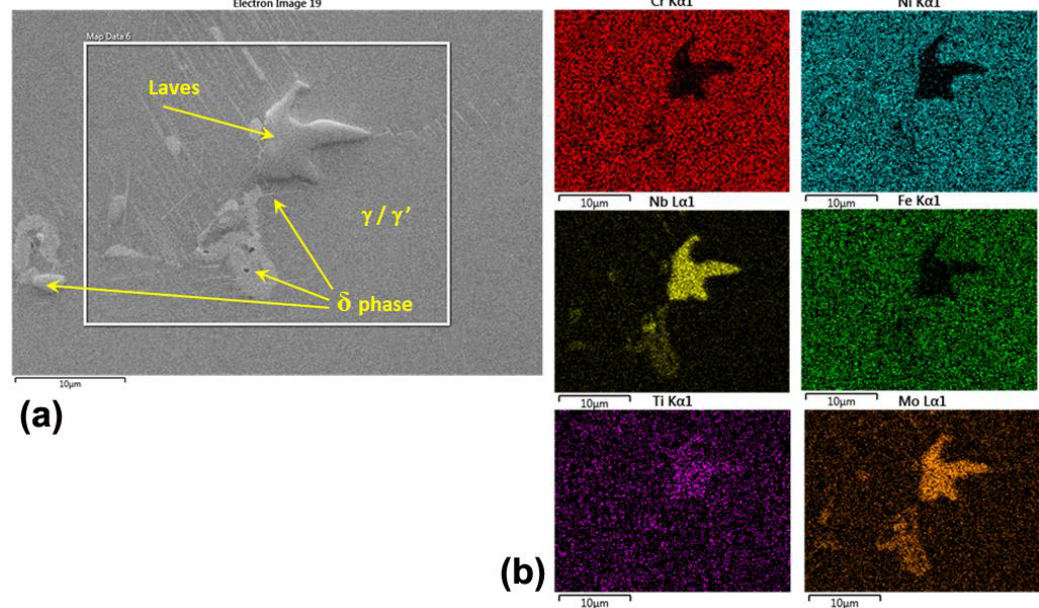
Figure 12. FESEM micrographs for IN718 alloy obtained by investment casting. ( a ): with standard heat treatment—TT0 (polished sample). ( b ): the respective x-ray elemental maps through EDS.